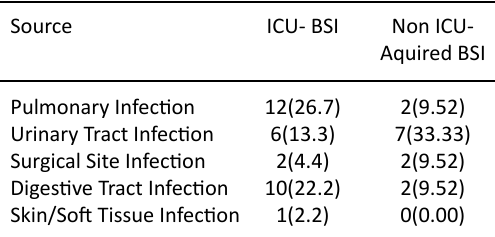
Table 4. Statistics of acquiring BSI from different sources of infection Source ICU-